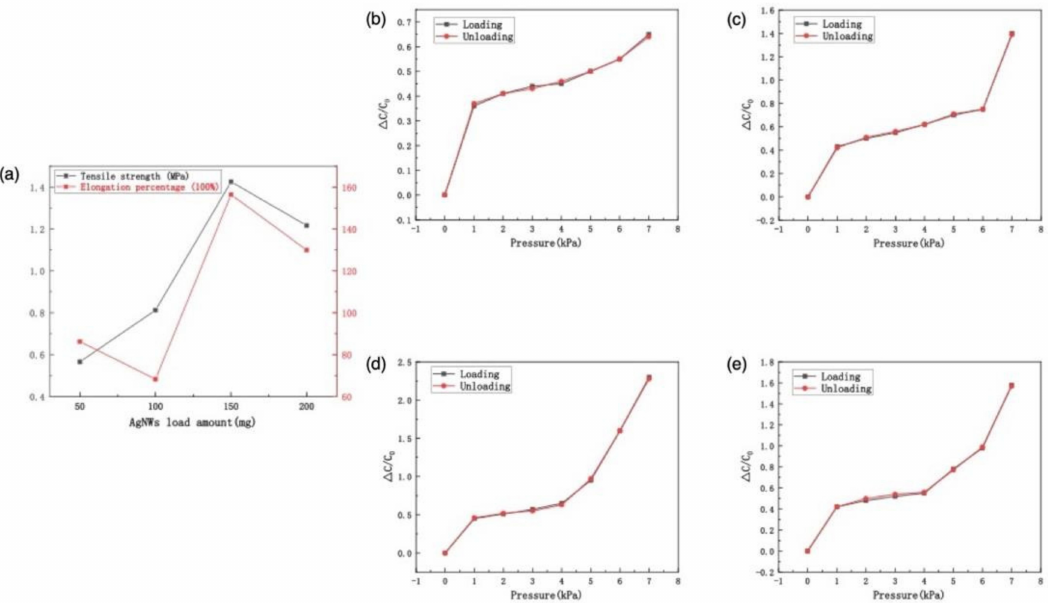
Figure 3. ( a ) The tensile strength and elongation percentage curve of four samples; The loading pressure curve and unloading pressure curve of the four sensors ( b ) P-1; ( c ) P-2; ( d ) P-3; ( e )